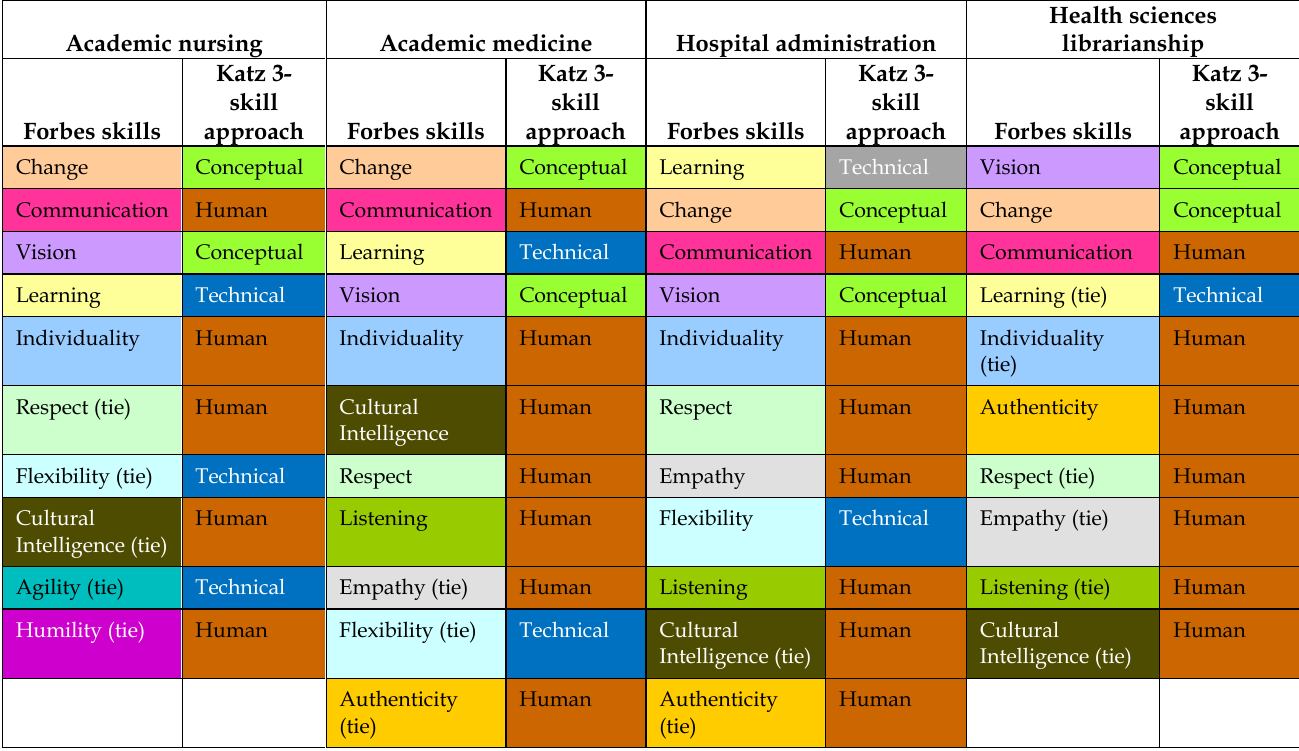
Table 1 Forbes Coaches Council skills and Katz’s skills mapped to each domain and from top-to-bottom in order of frequency (most frequent at top of